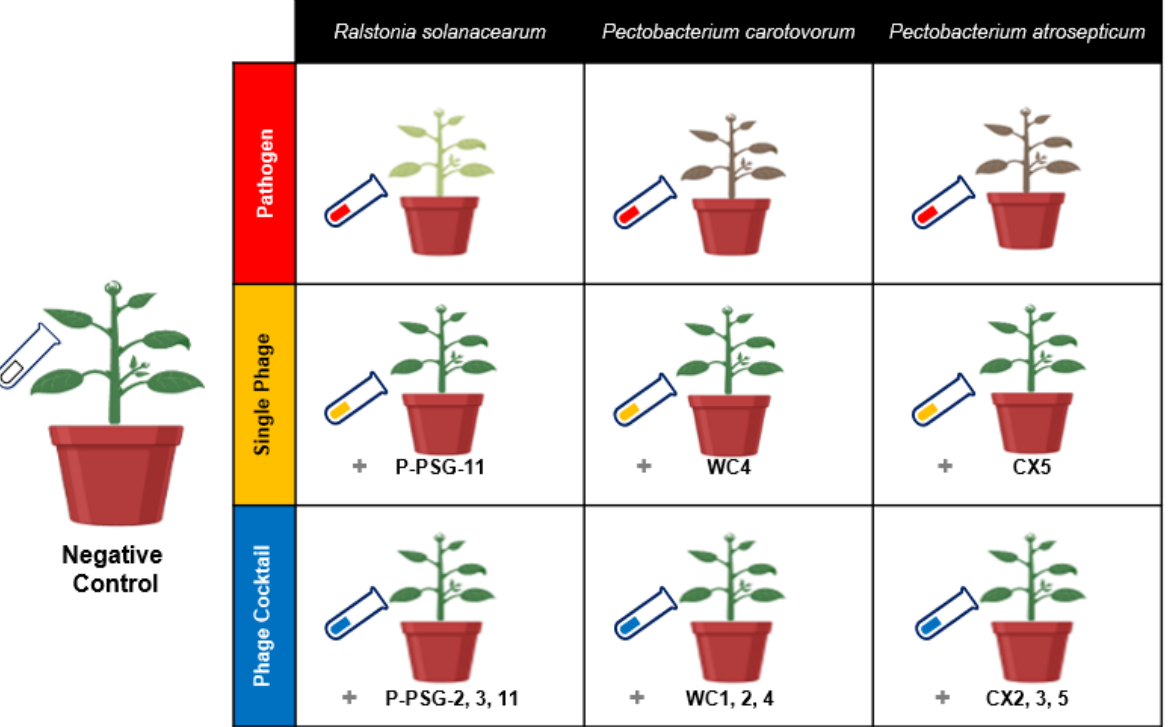
Figure 7. Illustration model for the biocontrol of the three groups, pathogens group Ralstonia solanacearum (Rs), Pectobacterium carotovorum (Pc) and Pectobacterium atrosepticum (Pa), single phage group SRs (PSG11), SPc (WC4) and SPa (CX5) and phage cocktail groups RsPck (P-PSG-2, 3, 11), PcPck (WC1, 2, 4) and PaPck (CX2, 3, 5), compared with negative control (no bacteria or phage added) in a greenhouse experiment.